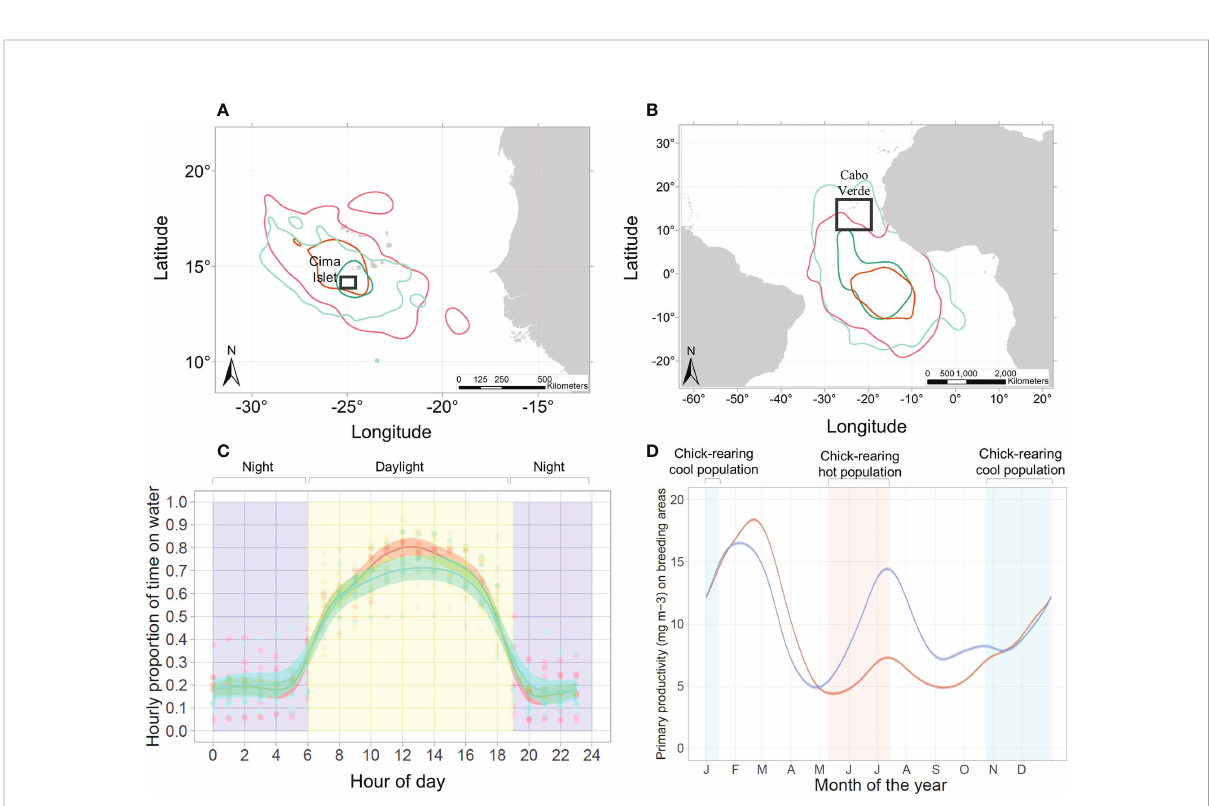
FIGURE 3 Niche overlap of both populations (cool population indicated by blue/green shading and hot population by orange/red shading) across different niche axes: (A) home-range and core area (95% and 50% kernel densities, respectively) during the breeding season for birds from the hot (N=95) and cool (N=122) populations; (B) home-range and core area during the non-breeding season for birds from the hot (N=11) and cool (N=8) populations; (C) daily activity patterns of birds from hot and cool populations, as determined from wet/dry data from geolocators and indicated by the proportion of time spent on the water during the non-breeding season (yellow background indicates day time and purple background indicated night time); GAMM shows the mean and the standard deviation interval, and (D) primary productivity in the marine areas used during the breeding season by the hot and cool populations; red background indicates the chick-rearing period of the hot season population, and blue background indicates the chick-rearing period of the cool season population. Sample sizes are summarized in Appendix S2.